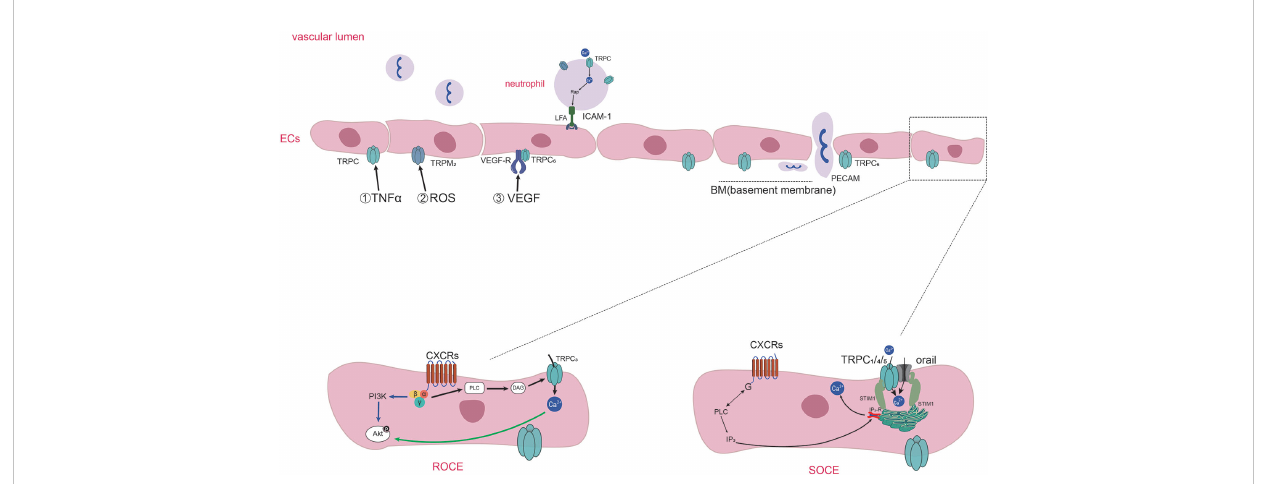
FIGURE 1 Diagram of TRPs-mediated Ca 2+ entering into endothelial cells and neutrophils chemotaxis and adhesion in in fl ammation. In fl ammatory stimuli (such as TNF- a , ROS, VEGF) in fl uence the expression and activation of TRPs expressed on ECs. Activation of speci fi c GPCRs on the cell surface causes the activation of PLC which cleaves the membrane phospholipid PIP2 into inositol 1,4,5-trisphosphate (IP3) and diacylglycerol (DAG). DAG induce the activation of TRPC3, TRPC6, and TRPC7 channels, and the way of the in fl ux of Ca 2+ called receptor operated Ca 2+ entry (ROCE). IP3 binds to IP3 receptors (IP3Rs) present on the ER, causing Ca 2+ release from intracellular stores. Then the Ca 2+ sensor stromal interaction molecule1(STIM1) proteins gather to the membrane of ER and activate the channels of orai1 and TRPC1/4/5, thus promoting extracellular Ca 2+ in fl ux which is called as SOCE. TRPCs also mediate the adhesion of neutrophils through regulating the anchor link of neutrophil and epithelial cells. TRPC6 expressed in endothelial cells colocalize with PECAM, surrounding leukocytes and promoting neutrophil trans-endothelial